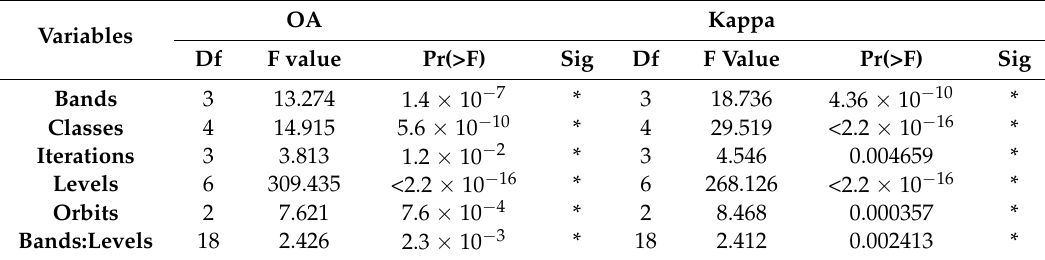
Table 7. Results from the global approach variance analyses performed (OA and k as numerical variables in every case). The asterisk (*) implies significant results with p -value < 0.05. F is the Fisher statistical value.